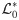
The Seifert circle decomposition of the link L0* (as shown in Fig 3) whose Seifert graph corresponds to G* on the top of Fig 8: each simple closed curve in the figure (drawn in different sizes and shapes, with the crossings ignored) is a Seifert circle.